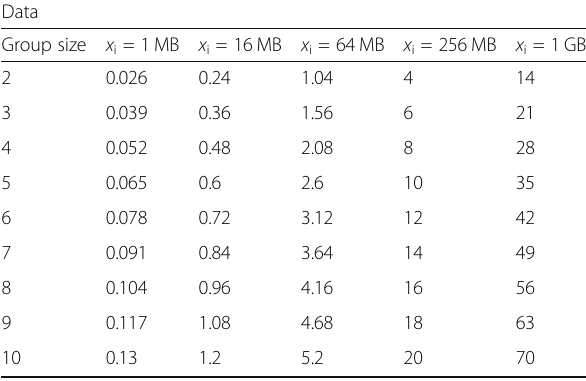
Table 1 Average data recovery times under various group sizes